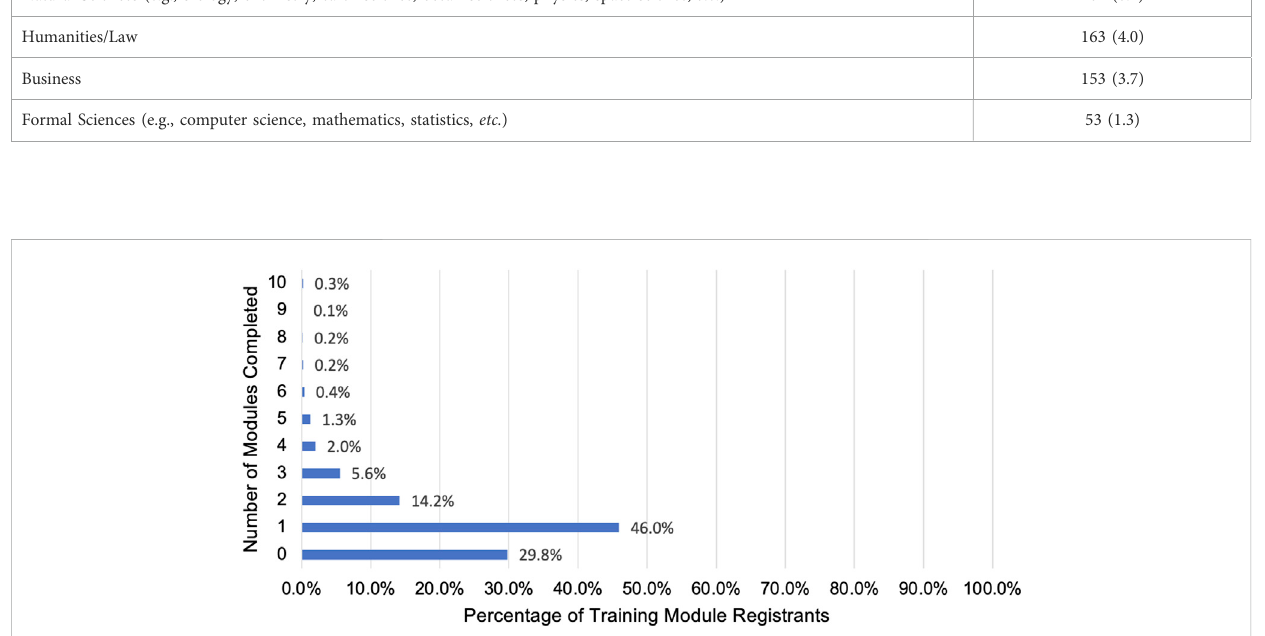
FIGURE 4 Number and percentage of CONVERGE Training Modules completed by each